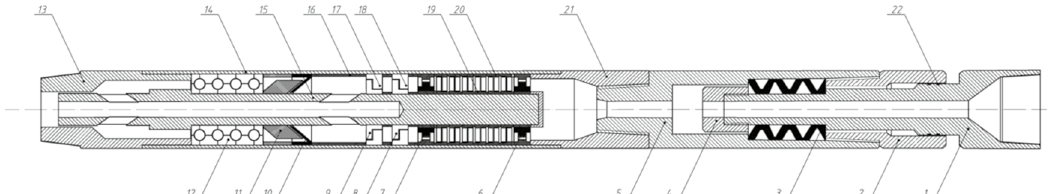
Figure 3. The structure of hydraulic oscillator driven with double valve